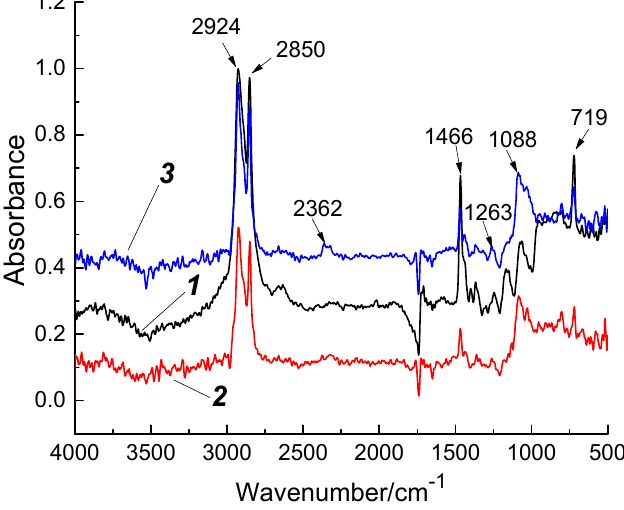
Figure 4. IR spectra: 1—neat GUR 2122; 2—“GUR 2122 + 10% LGF annealed” composite; 3—“GUR 2122 + 10% LGF annealed and treated with “KH-550”” composite.